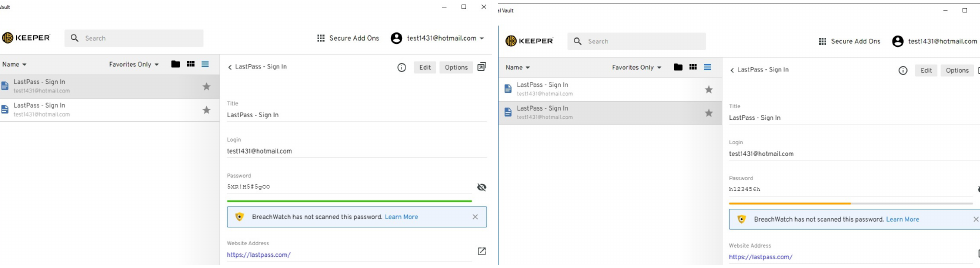
Figure A8. Keeper does not prevent users from storing different passwords for the same account.